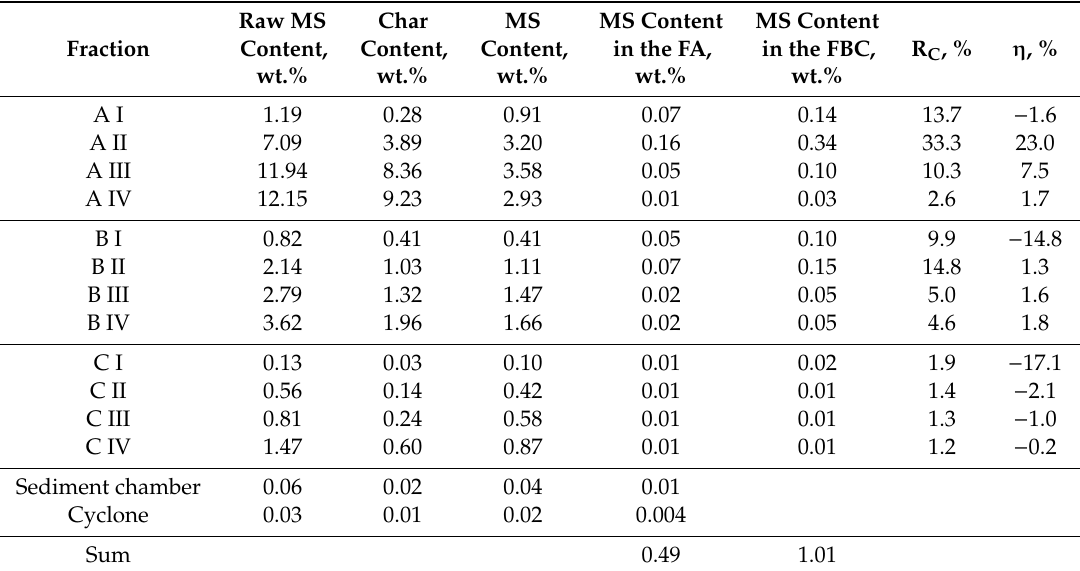
Table 4. The MS content in the fly ash FA 2